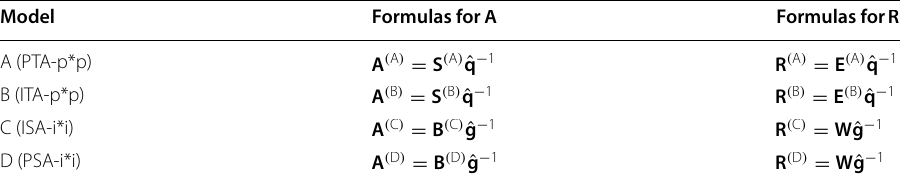
Table 3 Basic transformation models to derive IO coefficient matrices A and R from a SUT. After Eurostat (2008, p.